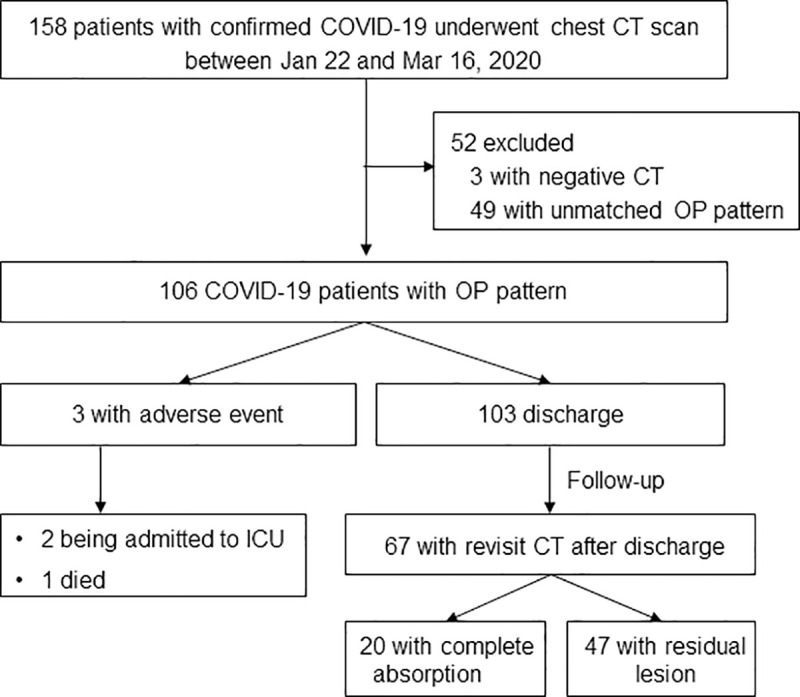
Patients recruitment flowchart.COVID-19 = coronavirus disease 2019, ICU = intensive care unit, OP = organizing pneumonia.